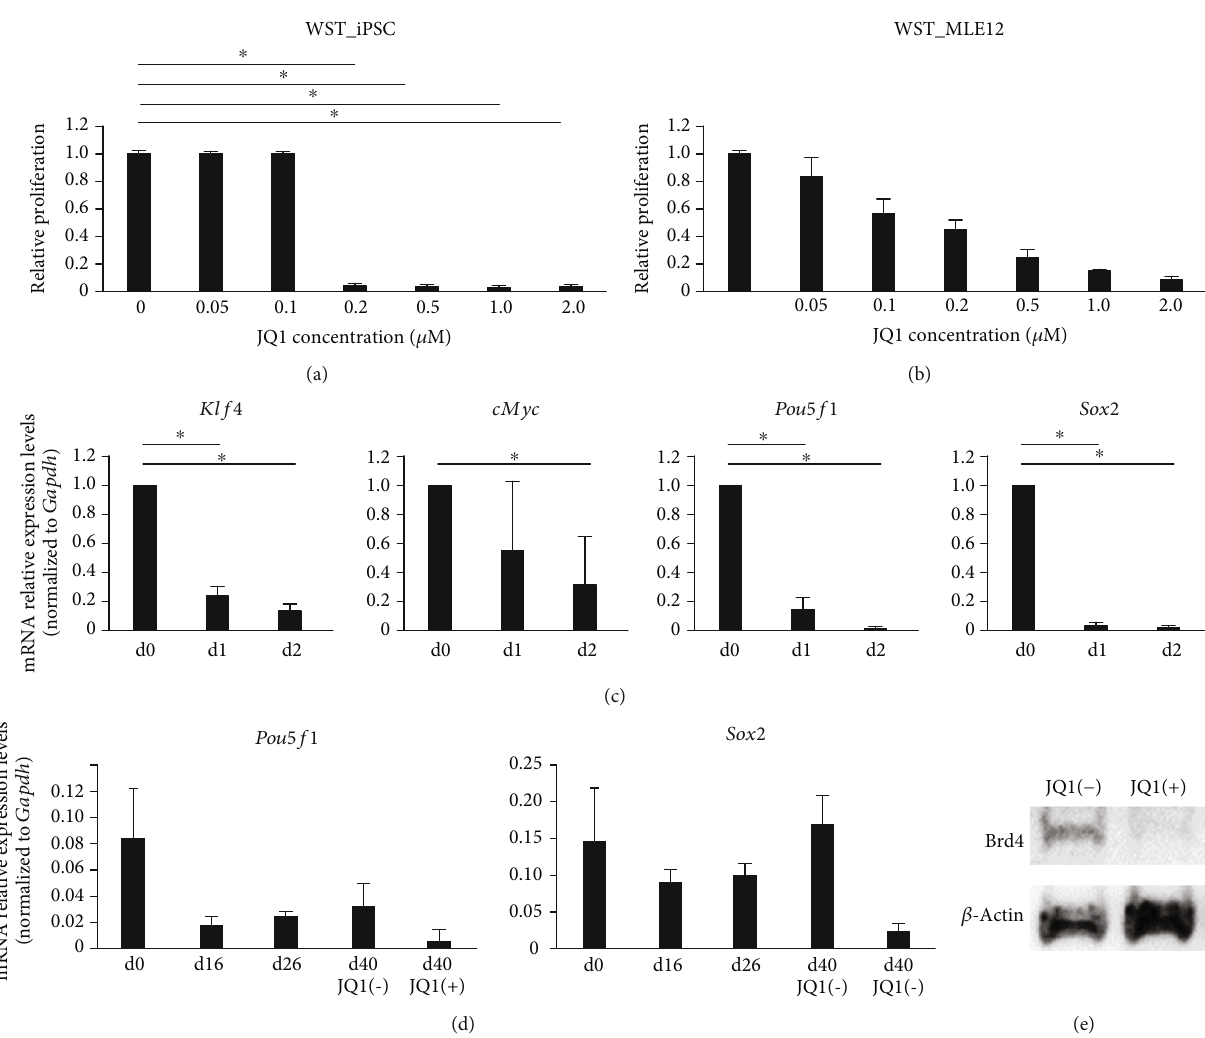
Figure 4: (a) E ff ect of JQ1 on the WST-1 reduction potential in undi ff erentiated iPSCs ( n = 3 ). Undi ff erentiated iPSCs were treated with 0, 0.05, 0.1, 0.2, 0.5, 1.0, or 2.0 μ M JQ1. ∗ P < 0 : 05 . (b) E ff ect of JQ1 on WST-1 reduction potential in MLE12 ( n = 3 ). Undi ff erentiated iPSCs were treated with JQ1 at 0, 0.05, 0.1, 0.2, 0.5, 1.0, or 2.0 μ M. (c) Quantitative polymerase chain reaction analysis in undi ff erentiated iPSCs ( n =4). Expressions of Klf4 , cMyc , Pou5f1 , and Sox2 mRNA. Expression ratios were normalized to the level of Gapdh expression. Expression levels were compared with those of undi ff erentiated cells (day 0). ∗ P < 0 : 05 . (d) Quantitative polymerase chain reaction analysis ( n = 3 ). Expressions of Pou5f1 and Sox2 mRNA. Expression ratios were normalized to the level of Gapdh expression. Pou5f1 and Sox2 mRNA expression levels were decreased. (e) Western blot analysis of undi ff erentiated iPSCs, with the expression of BRD4 protein